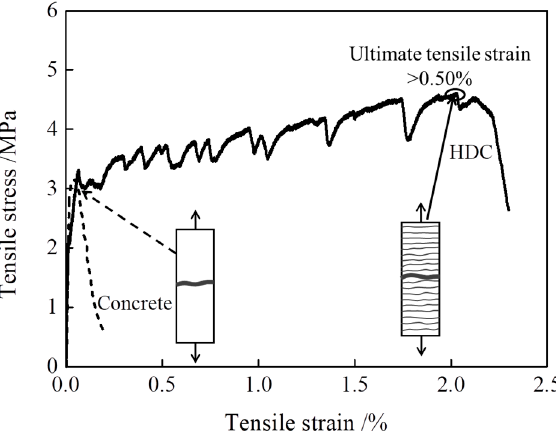
Figure 1. Schematic diagram of tensile stress–strain relationship curve and multiple cracking for HDC.